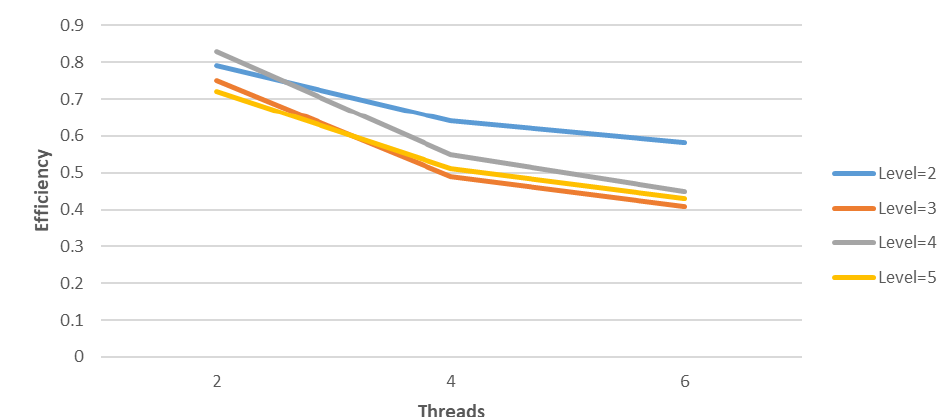
Figure 6. Efficiency of parallel V cycle of AGAMG in combination with deflation technique and MGenFAspI with droptol = 0 and l fill = 2 for 3D Poisson model problem with nx =